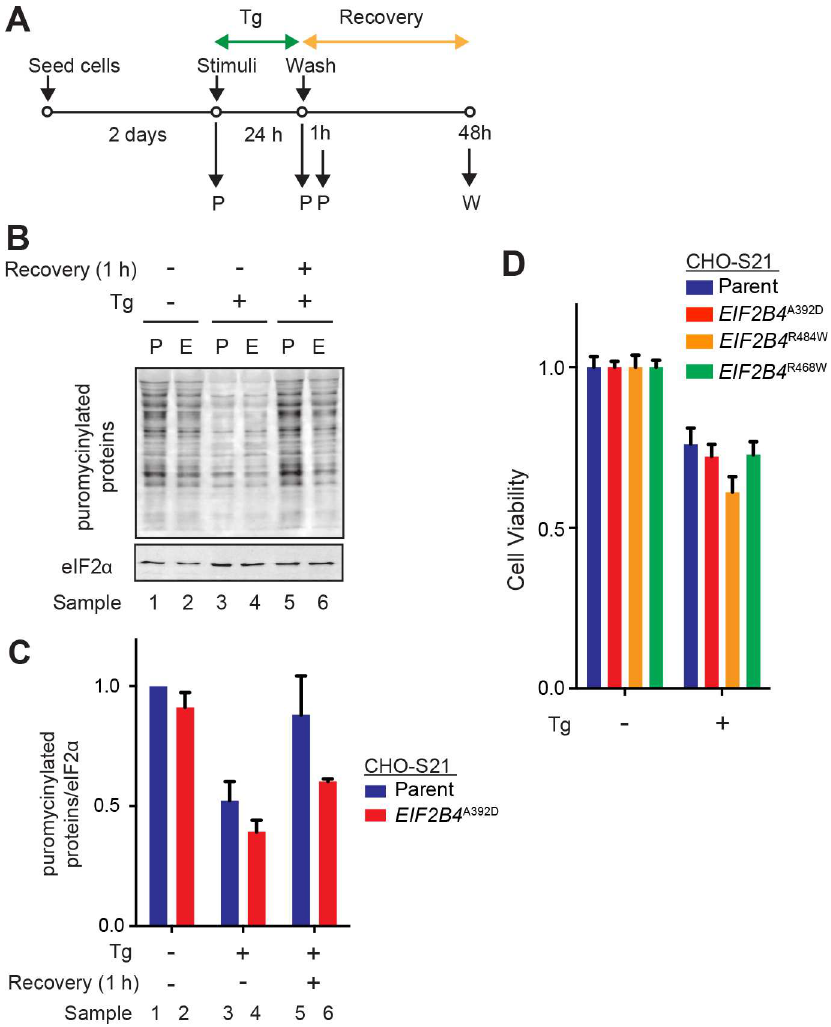
Fig 4. Stress-resistance of wildtype and VWM cells. (A) Schema of experiments to compare the effect of thapsigargin in parental CHO-S21 and VWM mutant cells. Cells were treated with thapsigargin (Tg; 250 nM) for the indicatedtime, washed free of compounds and allowedto recover before assay. W = WST-1 assay, P = Puromycin labeling.(B) Immunoblot of puromycinylated proteins followinga brief pulse of puromycin, reportingon levels of translation under the indicatedexperimental conditions. Shown is a representative experiment reproduced four times. P and E indicate parental CHO-S21 and EIF2B4 A392D mutant cells, respectively. (C) Quantification of “B”. Signal intensities of puromycinylated proteins were normalized by eIF2 α . Shown are means ± SEM of four independent experiments.(D) Cell viabilitymeasured by the WST-1 assay in the experiment describedin “A”. Shown are the mean ± SEM of four replicates of a representative experiment repeatedthree (R484W, R468W) to six (A392D)